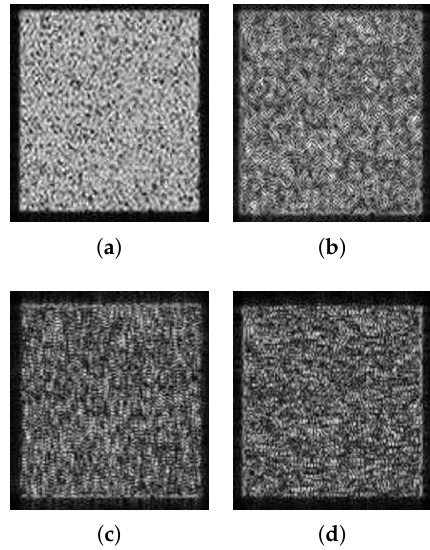
Figure 4. The imaging results of the rectangular areas. ( a ) Original image; ( b ) edge-enhanced SAR image; ( c ) azimuth direction edge-enhanced SAR image; ( d ) range direction edge-enhanced SAR